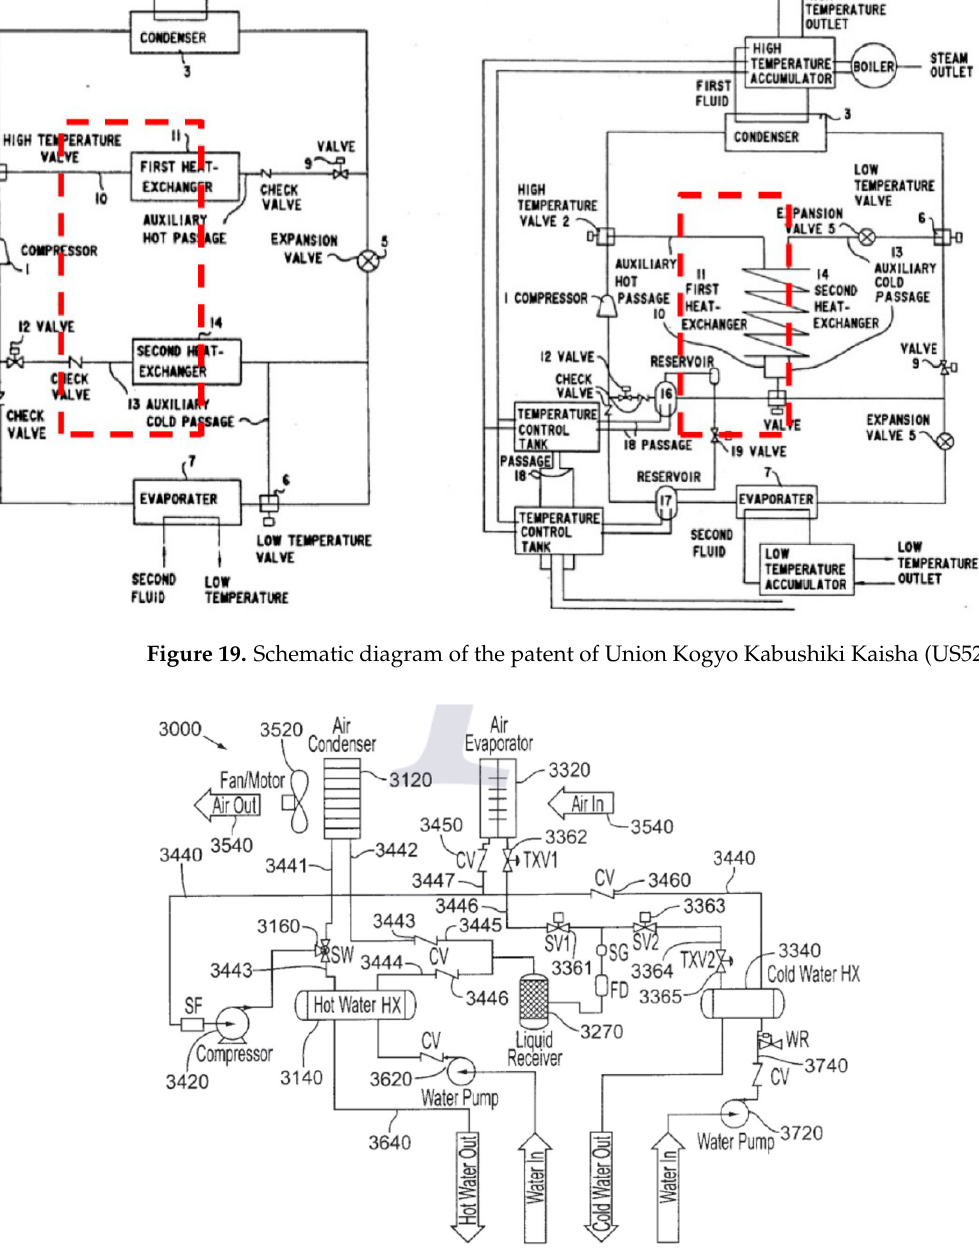
Figure 20. Schematic diagram of the patent of Jungwirth (US6751972).